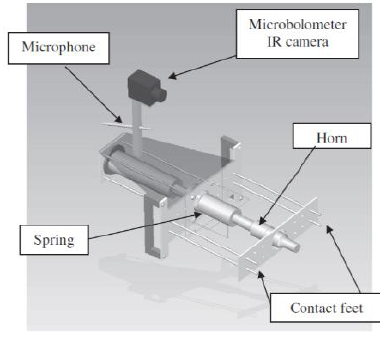
Figure 12. Experimental set-up of ultrasonic stimulated thermography, with permission from 98.